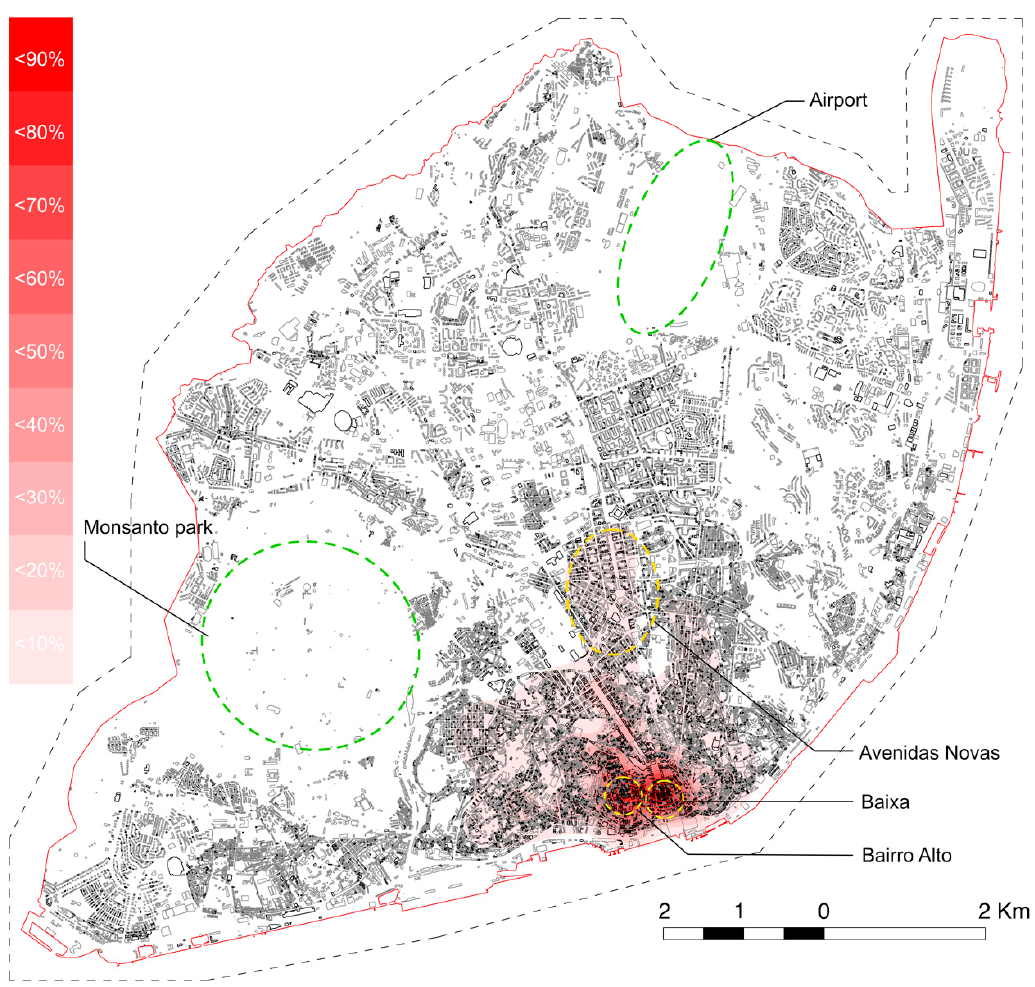
Figure 3. Adaptive KDE of building renovation permit requests in the 2010–2016 period in the city of Lisbon, h = 1800 m. Output of Grasshopper to Rhino. Source: Authors.